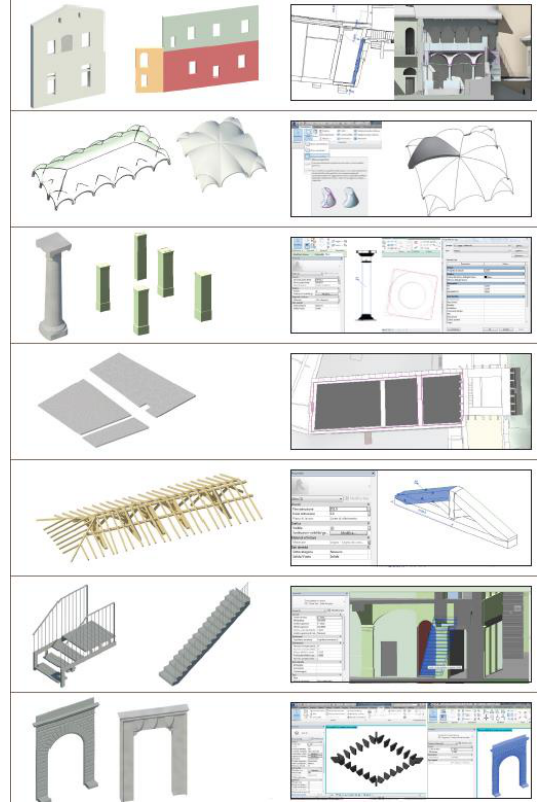
Fig. 5. The final BIM is made up of a combinations of objects with variable geometric complexity.